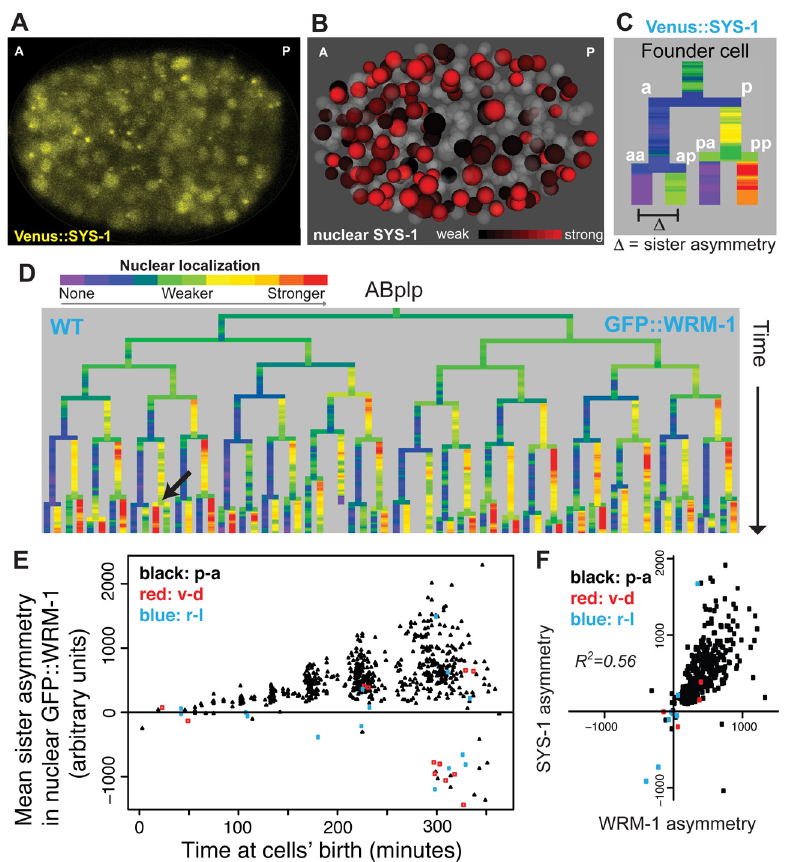
Fig 2. Nuclear localization of β -catenins is asymmetric across most embryonic cells. A) Confocal image of Venus::SYS-1 in a 350 cell stage embryo. B) Quantification of nuclear localization for Venus::SYS-1 shows that cells with strong nuclear localization of β -catenin (red) are distributed across the A-P axis. Grey cells have little to no detectable nuclear Venus::SYS-1. C) Overview of naming rules. Posterior daughter cells are represented as right branches on lineage trees. Sister asymmetry is measured by subtracting expression between daughter cells. D) Mean nuclear GFP::WRM-1 levels across the ABplp lineage. Branch color represents nuclear fluorescence intensity on a scale from purple (weak nuclear depletion) to green (weak nuclear enrichment) to red (strong nuclear enrichment). Note stronger enrichment in posterior daughters of later divisions and rare divisions with reversed polarity (black arrow). E) Mean sister asymmetry in nuclear GFP::WRM-1 for each division assayed through bean stage (~600 cells). Colors denote orientation of division according to Sulston. F) Correlation between mean GFP::WRM-1 and Venus::SYS-1 asymmetry for each division through the 350-cell